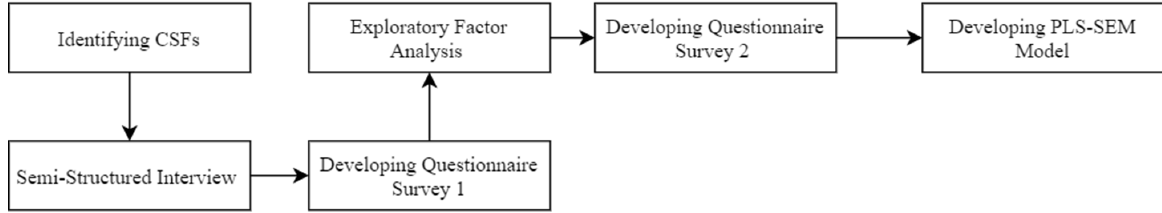
Figure 1. Research process.